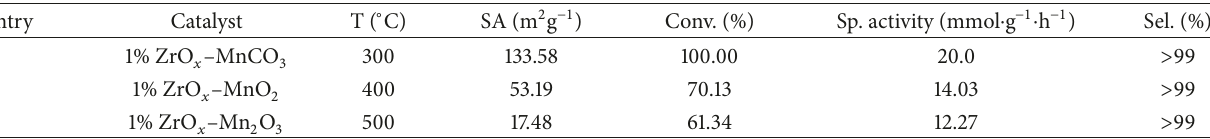
Table 1: Effect of the calcination temperature on the catalytic activities of 1% ZrO 𝑥 –MnCO 3 for the selective oxidation of 1-phenylethanol. [ a ]